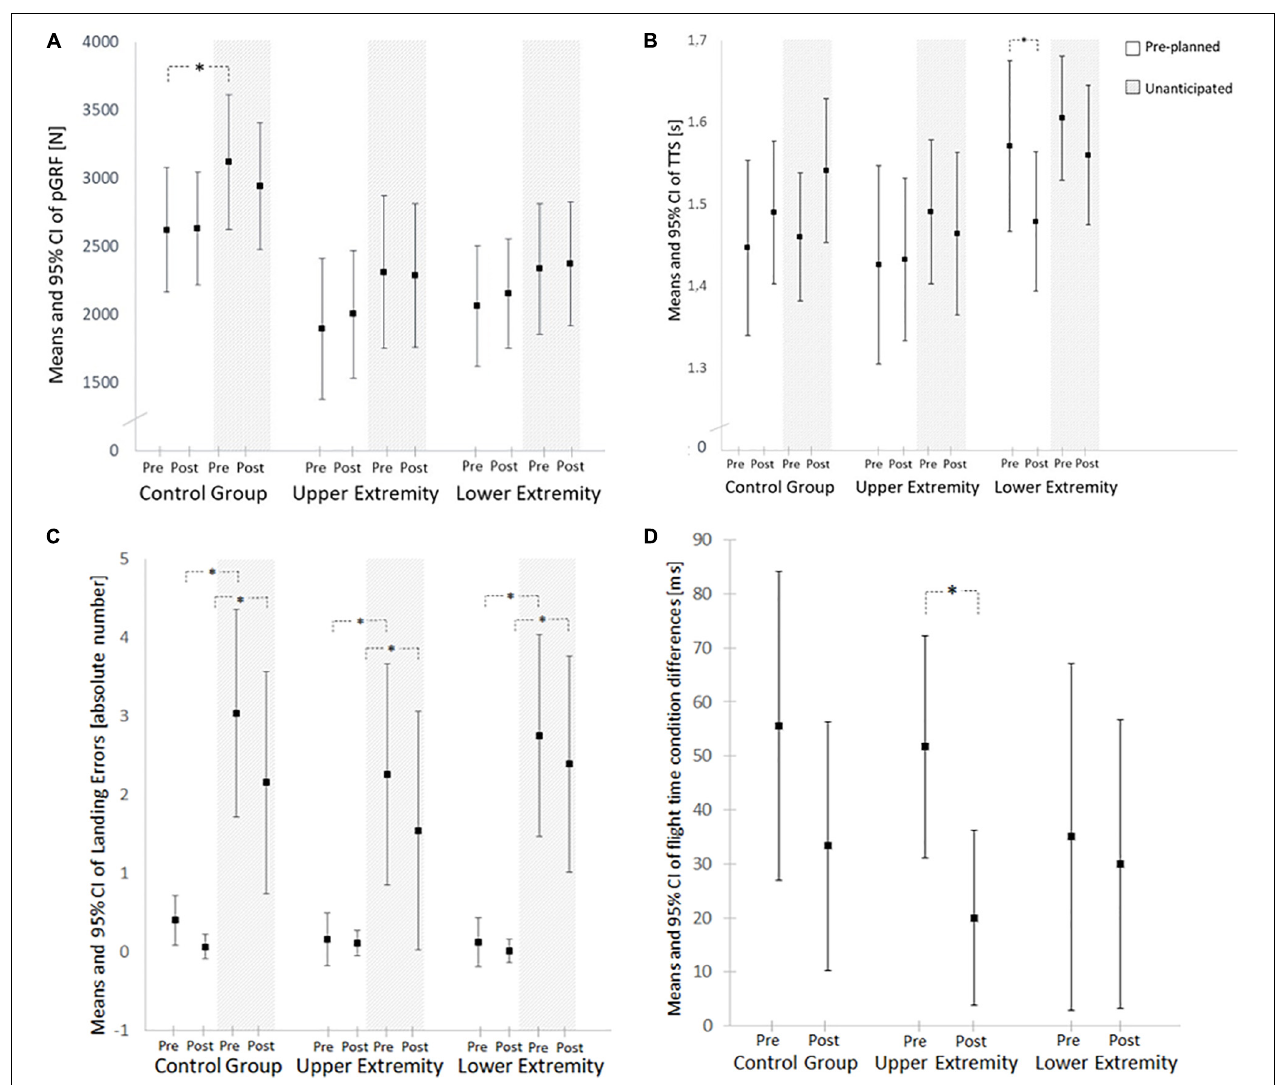
FIGURE 4 | Covariate adjusted means and 95% confidence intervals of the assessed parameters of pre-planned and unanticipated landings. (A) Peak ground reaction force (pGRF). (B) Time to stabilization (TTS). (C) Landing errors. (D) Flight time. N, newton; s, seconds; ms, milliseconds. Asterisk marks significant differences ( p ≤